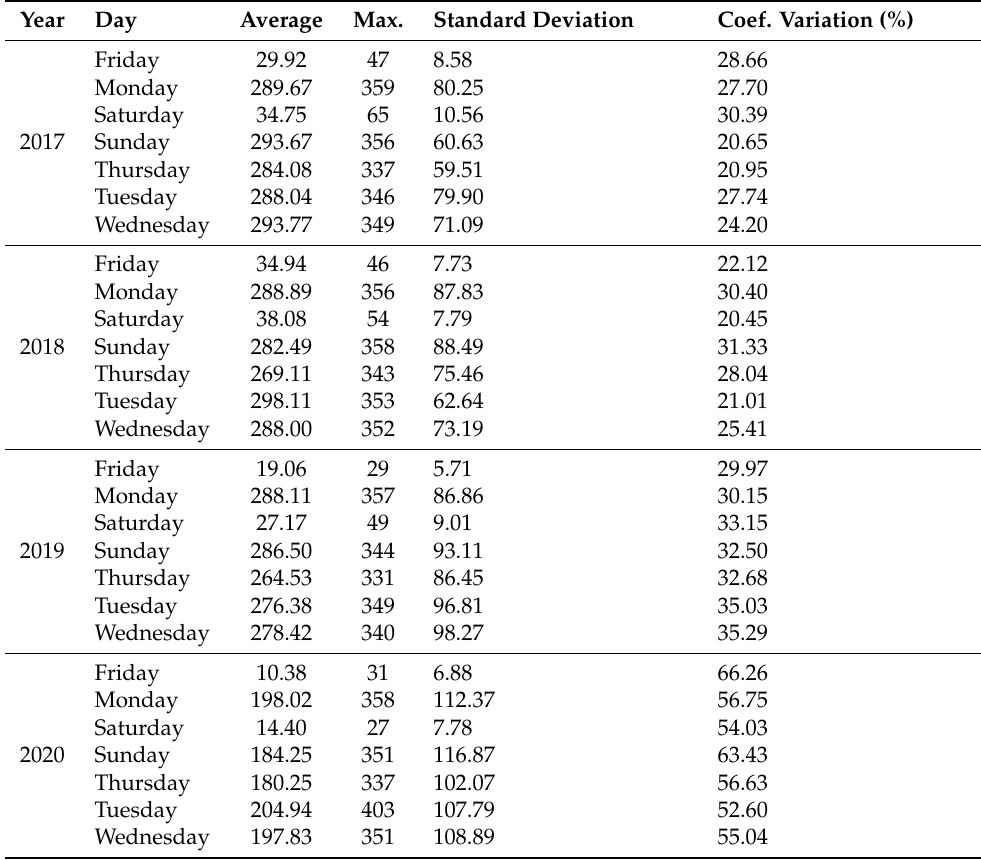
Figure 5. Daily whole blood donations, 2017–2021 (normalized data). Table 1. The 2017–2020 weekly blood supply